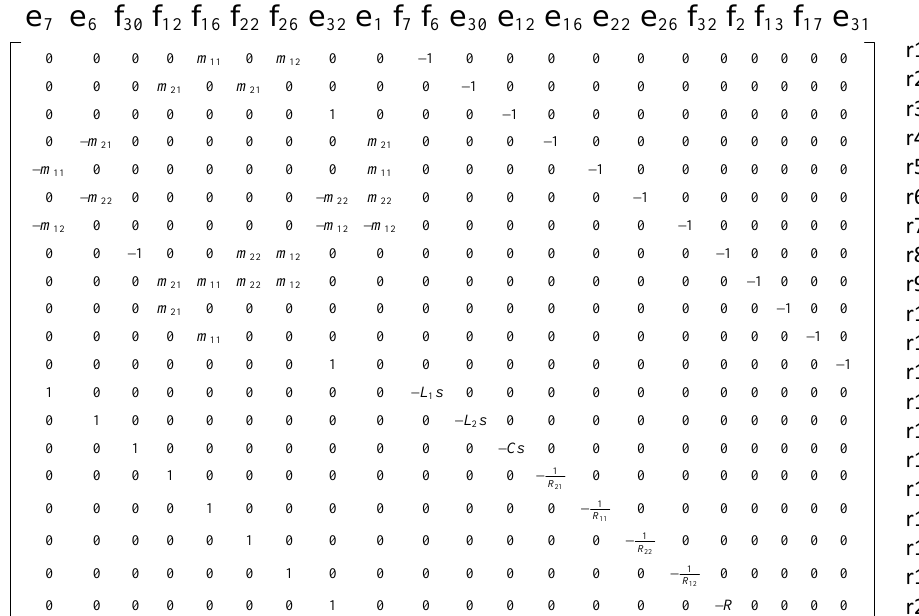
Figure 10. The matrix M